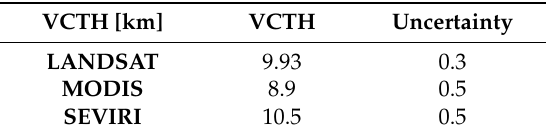
Table 1. Summary of the comparison between the different volcanic cloud-top height (VCTH) retrievals derived from Landsat 8, MODIS and